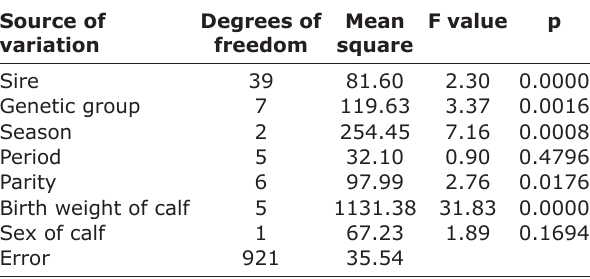
Table-2: Degrees of freedom, mean squares, F values and significance of sources of variation affecting gestation length in Jersey crossbred